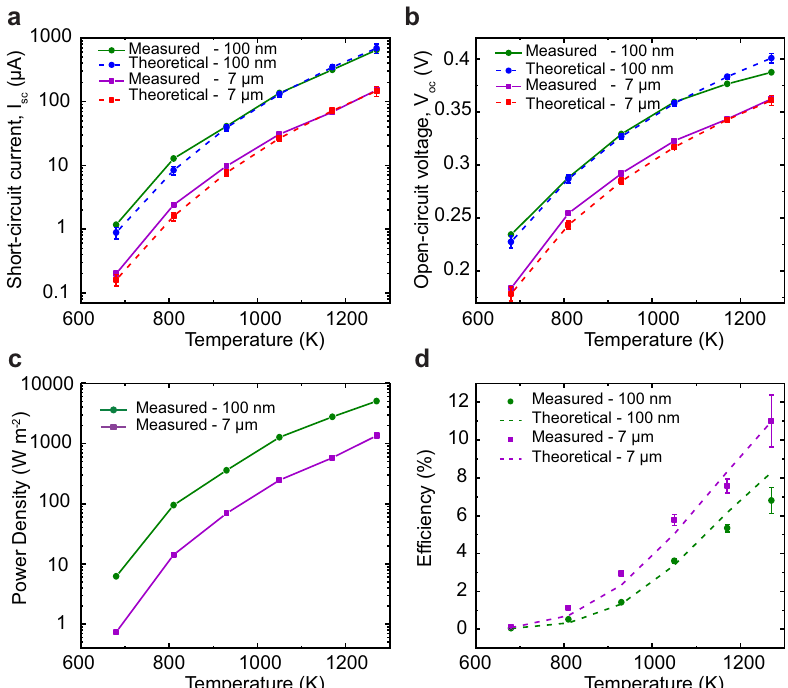
Fig. 5 Performance of near- fi eld thermophotovoltaic system (NFTPV). a, b Measured and calculated short-circuit current ( I sc ) and open-circuit voltage ( V oc ) as a function of temperature. Green circles and violet squares represent the experimental data points, while blue circles and red squares represent the calculated data points with the corresponding uncertainties, at gap sizes of 100 nm and 7 μ m, respectively. Solid and dashed lines added as a guide to the eye. c The measured power density ( P MPP per unit area of the PV cell) is plotted as a function of temperature at two gap sizes, one in the far fi eld (violet squares) and other in the near- fi eld (green circles, solid lines plotted as visual guide). d Ef fi ciency of NFTPV system at different temperatures for two gap sizes, de fi ned as the ratio of the measured power output ( P MPP ) and theoretical radiative heat transfer ( Q RHT ), calculated at T emitter with an uncertainty of ± Δ T , where Δ T = 27 K for T = 1270 K and 10 K otherwise. The dashed lines represent theoretical estimates of the ef fi ciency based on our emitter